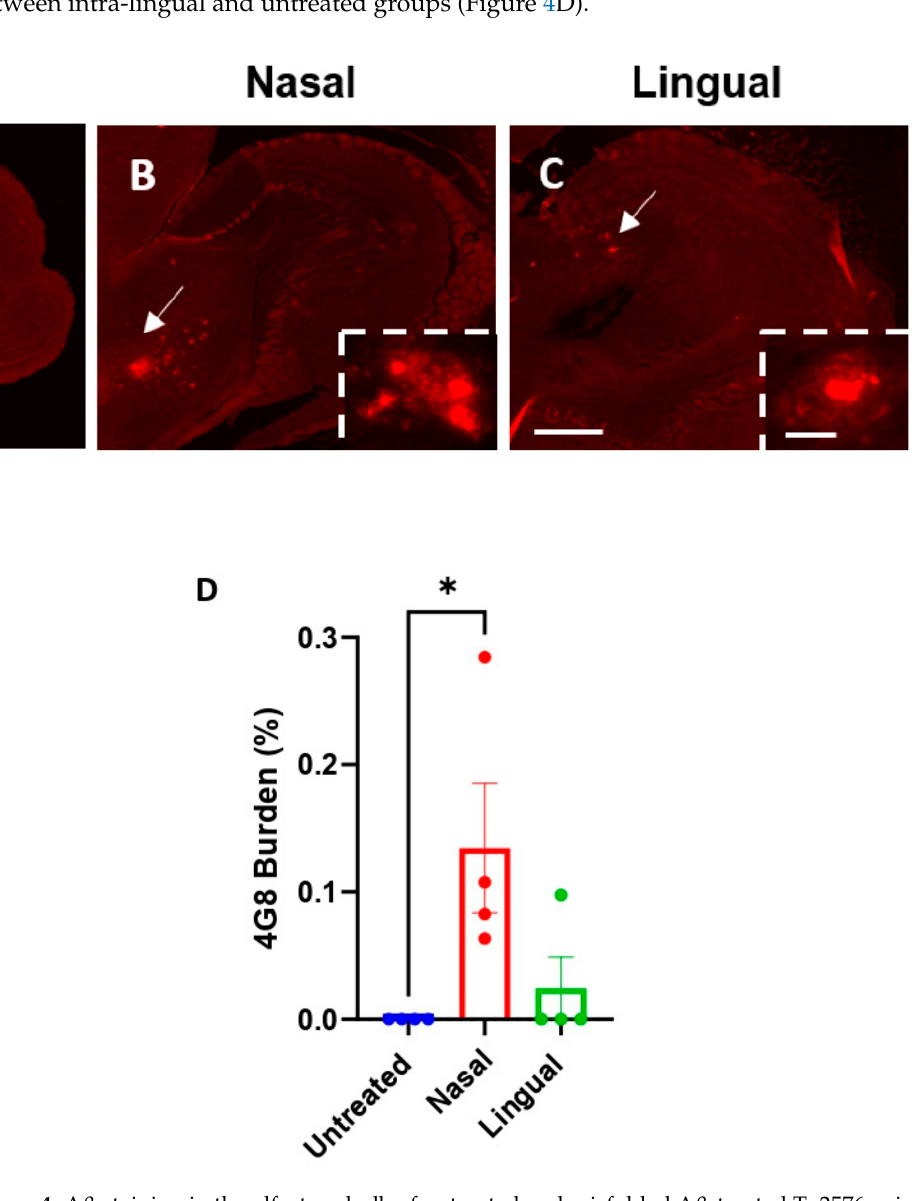
Figure 4. A β staining in the olfactory bulb of untreated and misfolded A β -treated Tg2576 animals. Representative pictures of 4G8 immunofluorescence in the olfactory bulb of untreated animals ( A ) and mice treated with A β -laden BH via extra-nasal or intra-lingual administration, White arrows denote amyloid deposits ( B , C ). 4G8 burden (%) quantification in the olfactory bulb ( D ) was statistically analyzed using One-way ANOVA and Tukey test (* p < 0.05). Values are expressed as mean ± SD. Scale bar represents 100 µm and 50 µm (insets).